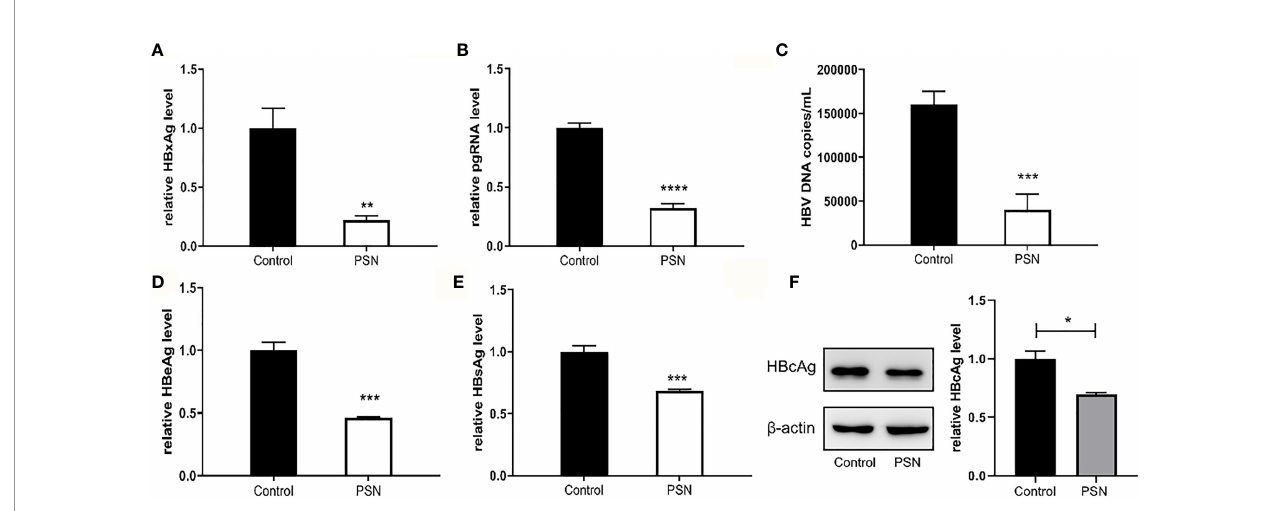
FIGURE 7 | Inhibitory effect of nanoparticles on HBV, when nanoparticles and HBV simultaneously act on HepG2-N6. (A, B) Inhibitory effect of nanoparticles on HBxAg mRNA and pgRNA in cells. (C – E) Inhibitory effect of nanoparticles on HBV DNA, HBeAg and HBsAg in supernatant. (F) Western blot analysis of HBcAg expression in HepG2-N6 cells infected HBV, and expression after PSN treatment. Data are represented as the mean ± SD from at least three independent experiments. * P < 0.05, ** P < 0.01, *** P < 0.001, **** P <